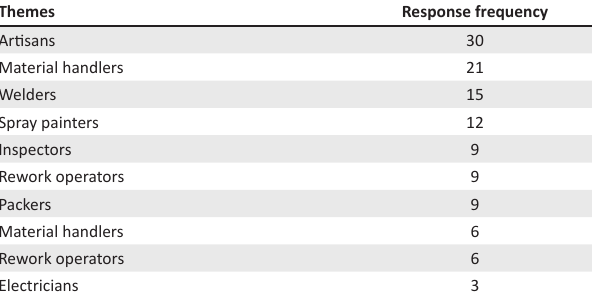
TABLE 4: Types of jobs lost as a result of the introduction of Robotics. TABLE 5: Types of jobs created as a result of the use of